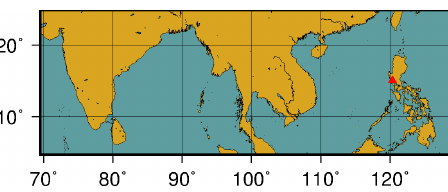
Figure 1. Location of Mt. Pinatubo marked by the triangle in the simulation domain (69.5 ◦ E, 4.5 ◦ N to 130 ◦ E, 25.5 ◦ N).